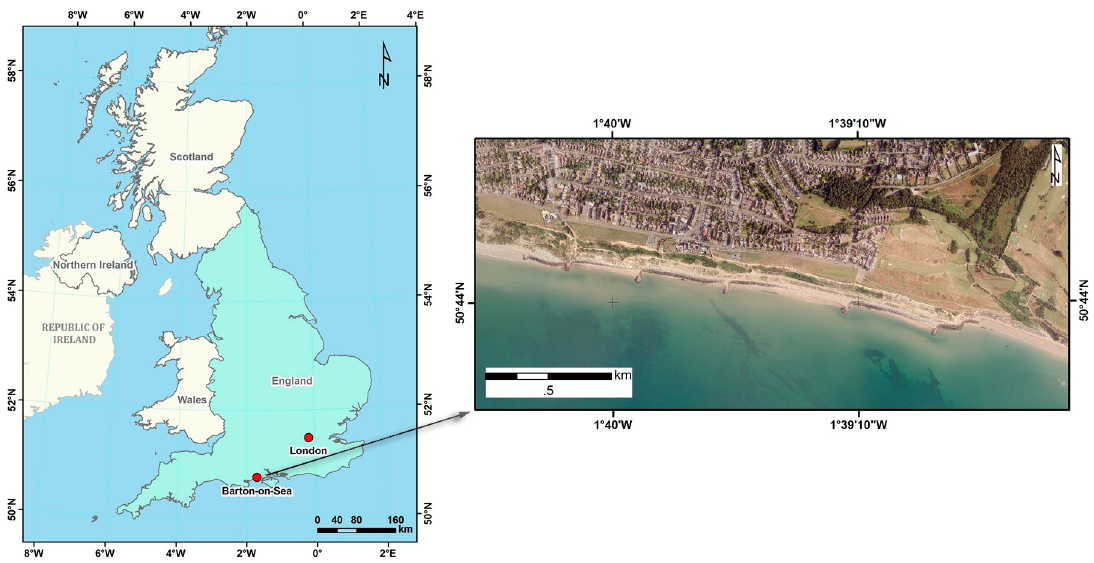
Figure 1. Study area: Barton-on-Sea coastal frontage.